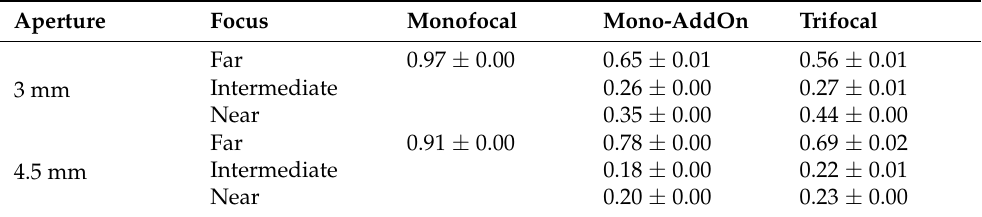
Figure 3. Strehl Ratio as a function of defocus. A higher Strehl Ratio indicates a better optical quality. Both the trifocal and AddOn IOL showed two peaks, corresponding to the far and near focus. Table 1. Strehl ratio values of the analyzed lenses measured at the best far, near and intermediate focus.